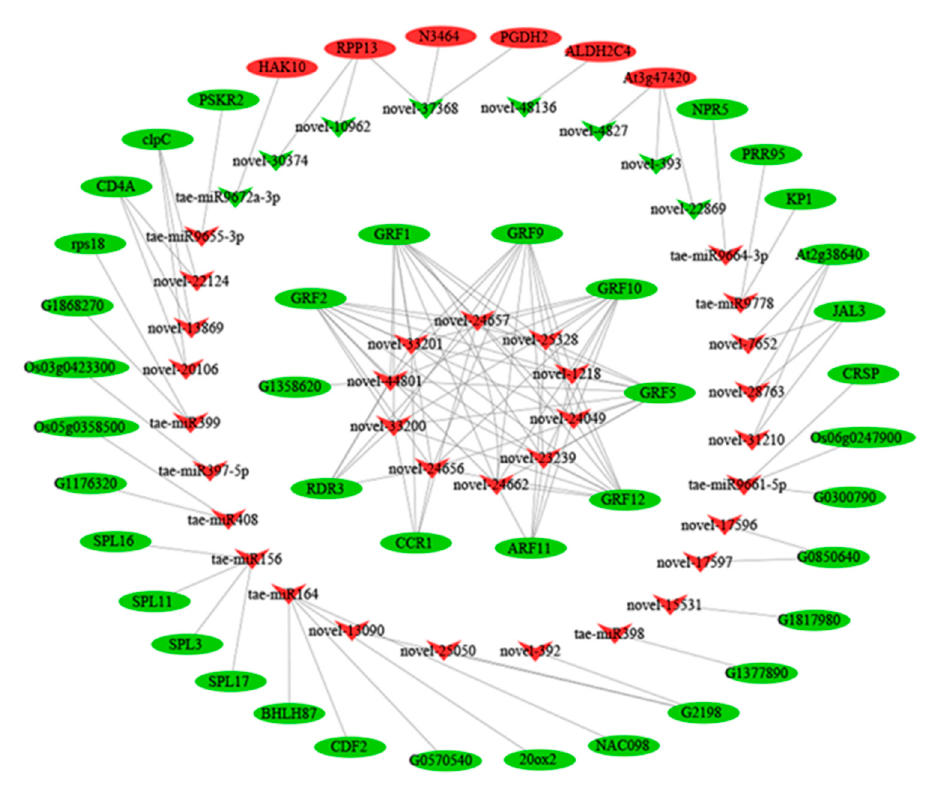
Figure 10. Negative regulation networks between the key DEMs and their target DEGs in dmc. The red indicates highly expressed in dmc , the green indicates lowly expressed in dmc , ellipses indicate DEGs, arrowheads indicate DEMs, the lines indicate the regulation relationship.